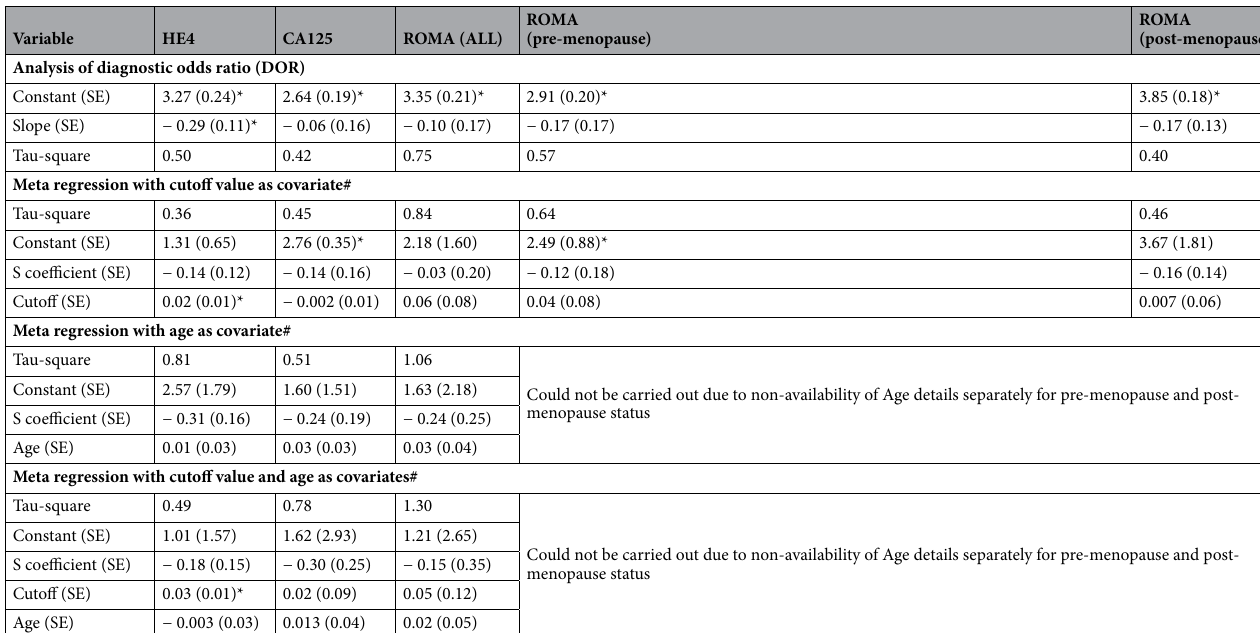
Table 3. Results of meta regression analysis to assess causes of heterogeneity. *Coefficients are statistically significant at P < 0.05, Human epididymis secretory protein 4 (HE4), Cancer antigen (CA125) and Risk of of the variance of diagnostic Odds Ratio and between study variance was estimated by Random Effect Model